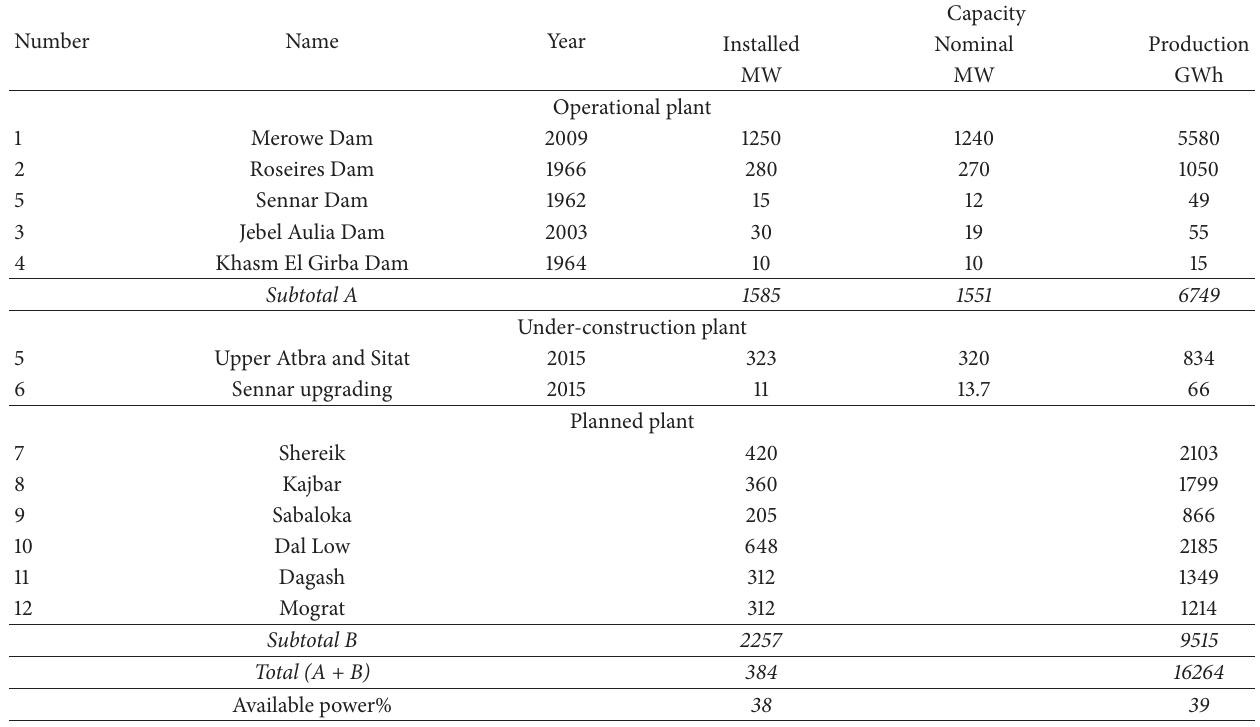
Table 2: Hydroelectric power plant (operational, under construction, and planned).